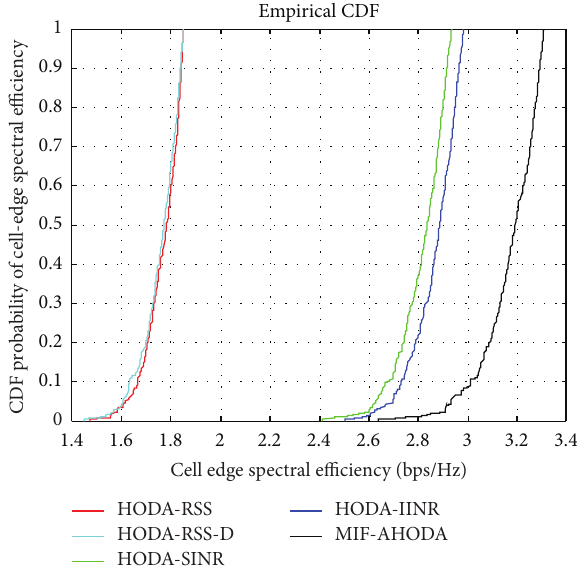
Figure 6: Average user’s cell-edge spectral efficiency.